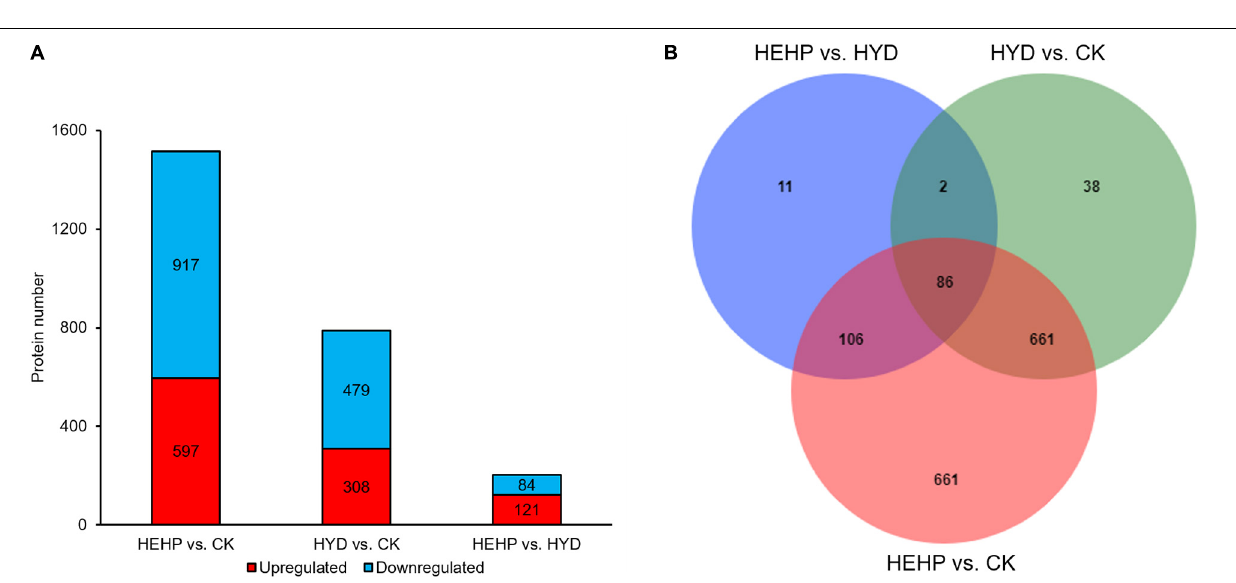
Frontiers in Plant Science |